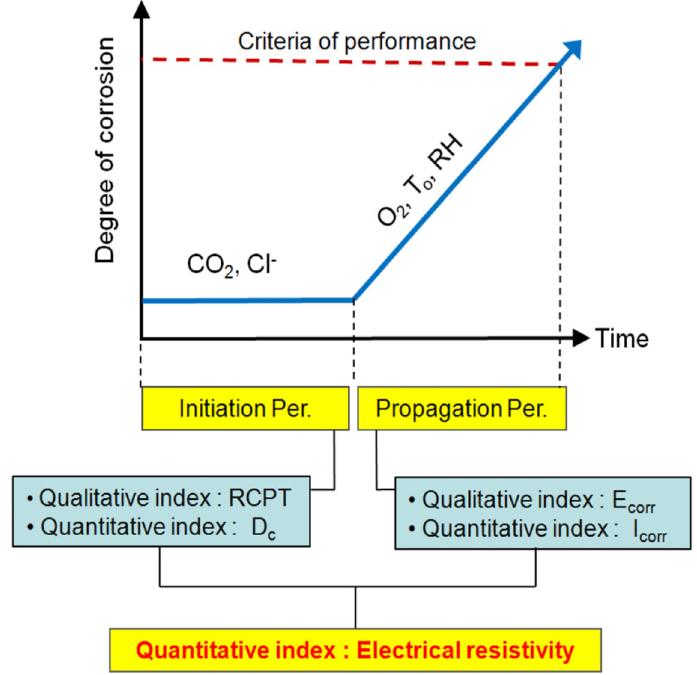
Figure 1. Modified schematic sketch of the steel corrosion sequence in concrete (updated from [3]).